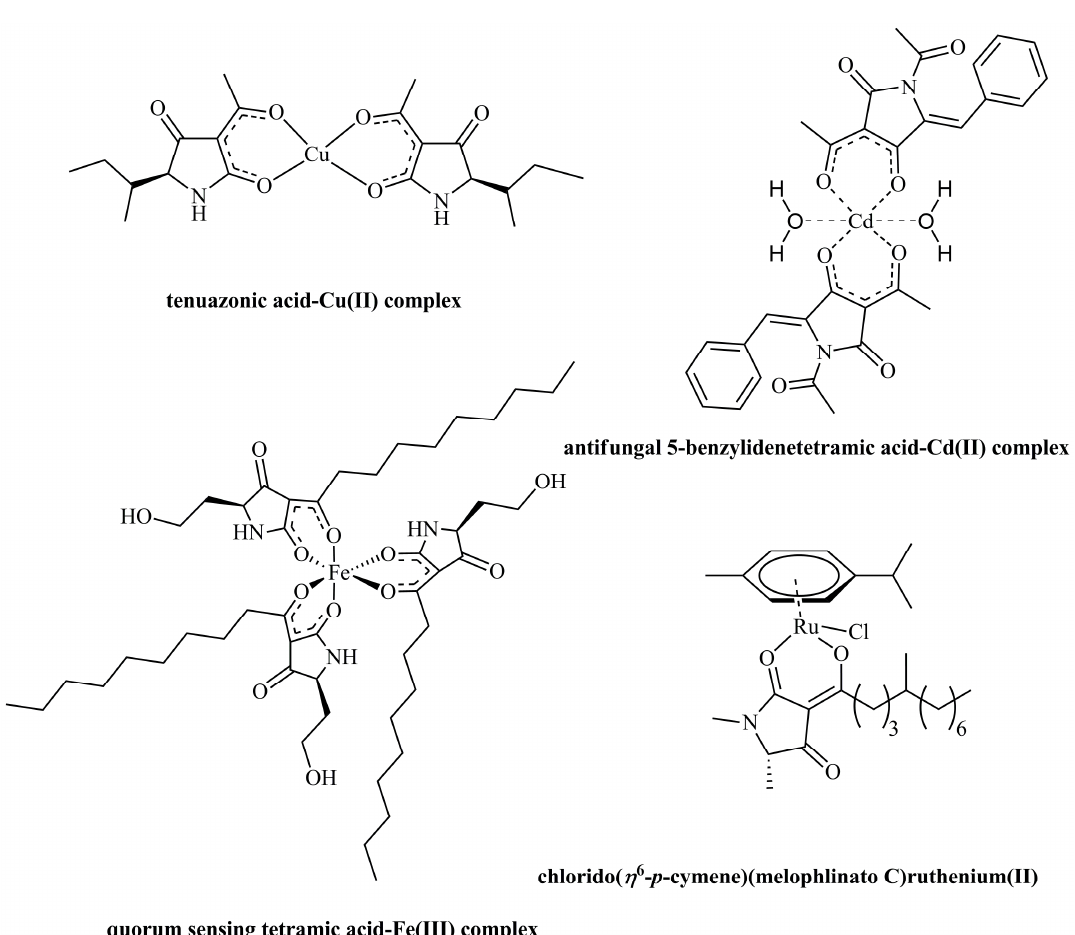
Figure 2. Tetramic acid metal complexes with divalent or trivalent ions.